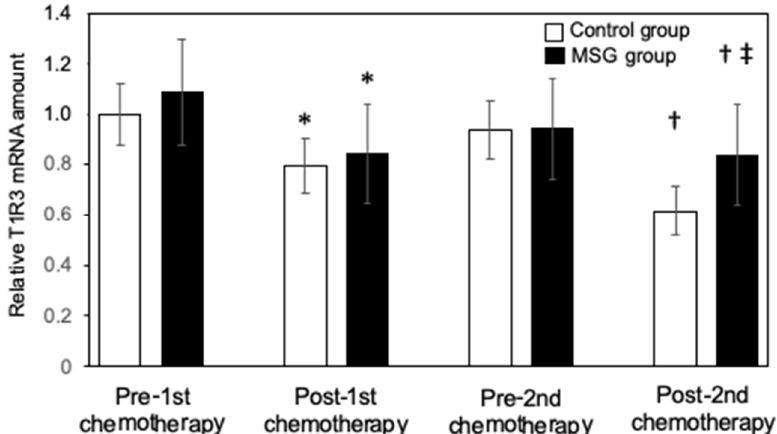
Figure 1. Effect of dietary monosodium glutamate (MSG) supplementation on chemotherapy-induced downregulation of T1R3 expression in the tongues of patients with head and neck cancer. Lingual T1R3 expression levels were measured in patients randomly assigned to the control ( n = 26) and MSG ( n = 25) groups immediately before and 1 week after the first and second doses of chemotherapy. Data are represented as the mean ± standard deviation and are expressed relative to the pre-first chemotherapy value for the control group. * p < 0.05 vs. the corresponding value for the pre-first chemotherapy, † p < 0.05 vs. the corresponding value for pre-second chemotherapy, ‡ p < 0.05 vs. the corresponding value for the control group as determined by the Kruskal–Wallis test and two-way ANOVA analysis of variance. If an overall significant difference was detected, the Tukey–Kramer test was applied to identify pairs showing significant differences.